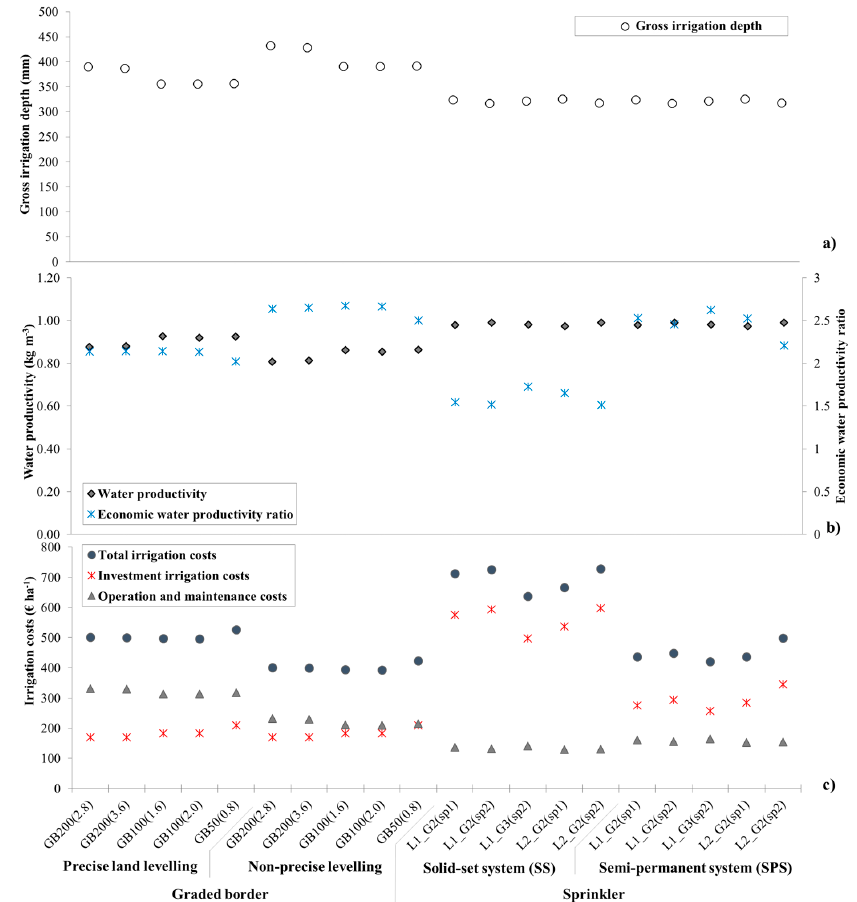
Figure 9. Comparing borders and sprinkler irrigation alternatives for: ( a ) gross irrigation depth, GID (mm); ( b ) water productivity, WP (kg ∙ m − 3 ) and economic water productivity ratio, EWPR; and ( c ) irrigation costs (€ ∙ ha − 1 ). Border lengths are of 50, 100 and 200 m, and inflow rates (L ∙ s − 1 ∙ m − 1 ) are in brackets. Sprinklers refer to layouts L1 and L2; spacings are G2 and G3; and sprinkler types are sp1 and sp2. Water 2017 , 9 , 50